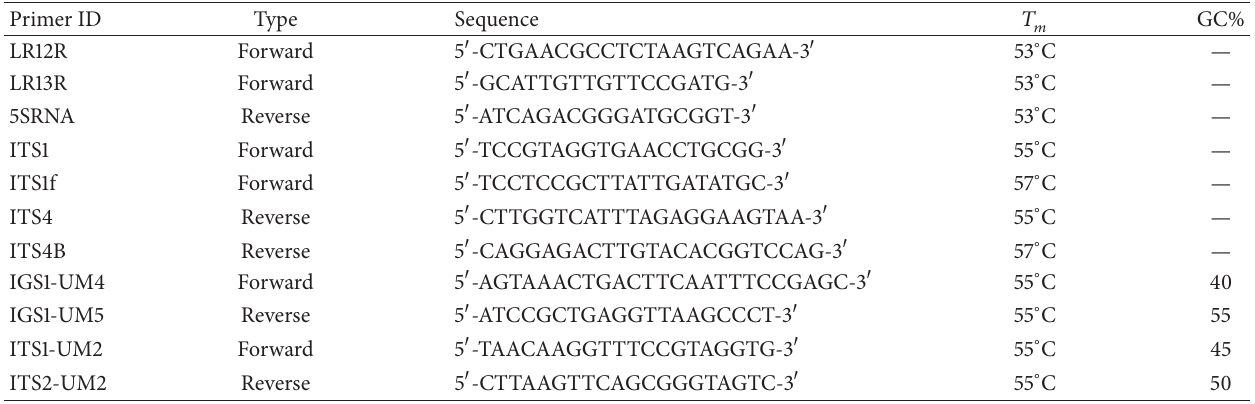
Table 2: List of designed and referenced PCR primers used in this